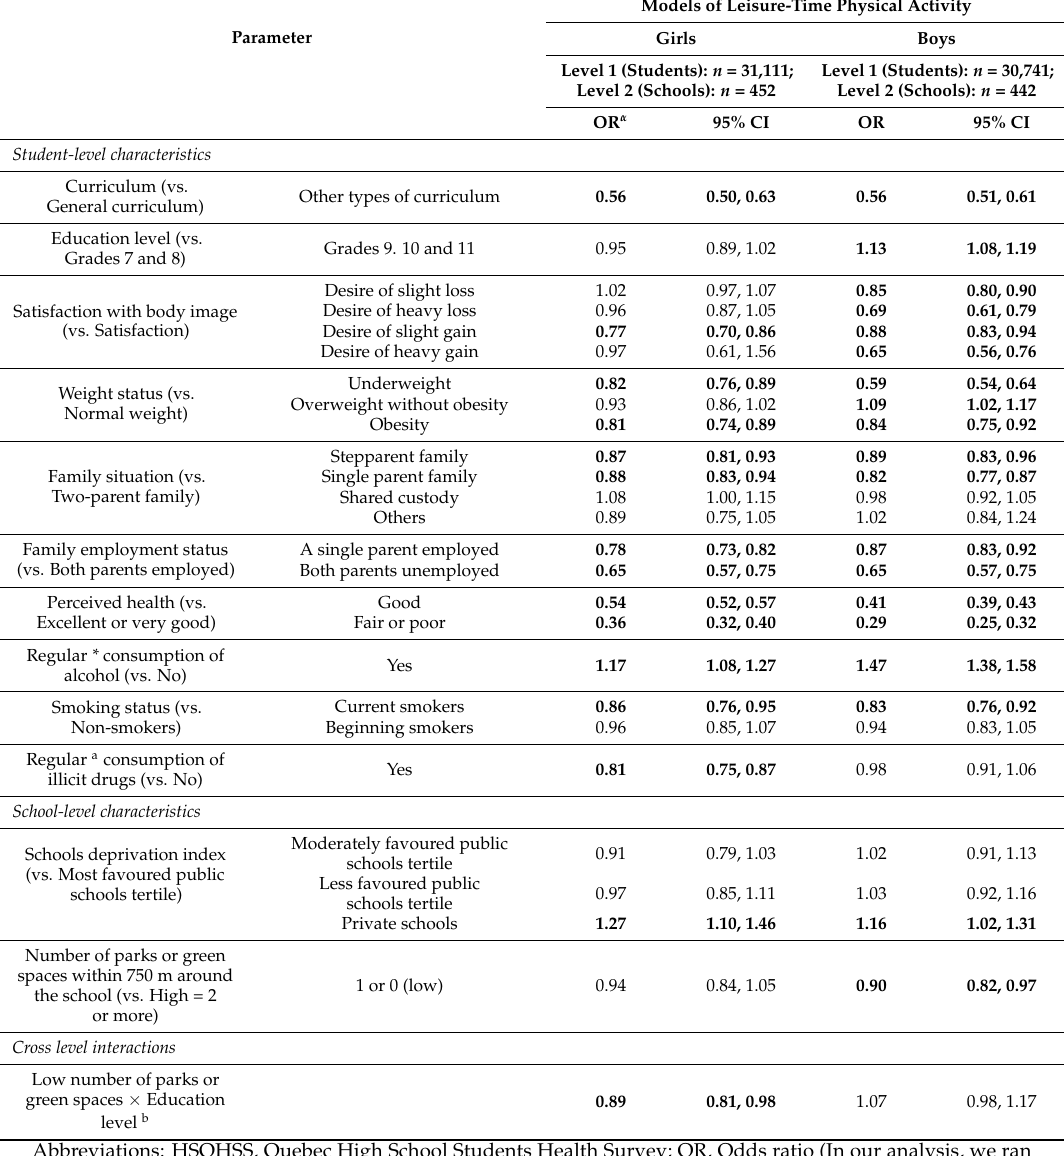
Table 3. Correlates of Leisure-Time Physical Activity Among Adolescents Involved in the QHSSHS, Quebec, 2010–2011 (with Multiple Imputation). Models of Leisure-Time Physical Activity Parameter Girls Boys Level 1 (Students): n = 31,111; Level 2 (Schools): n =